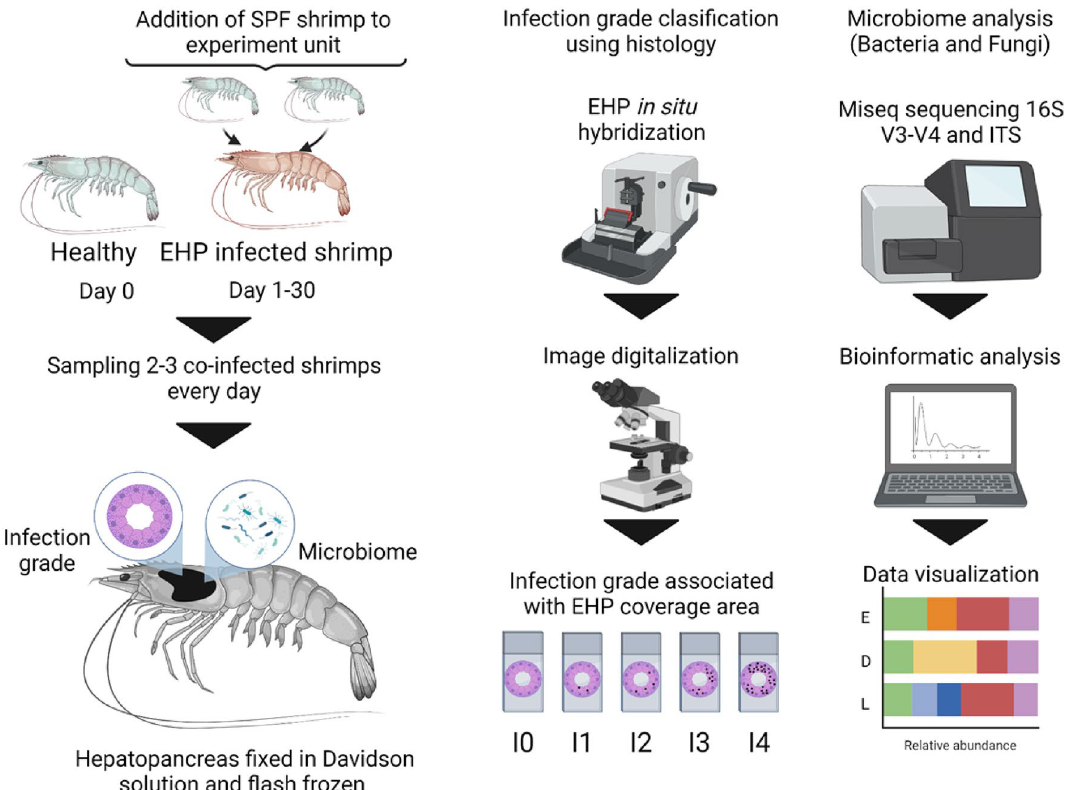
Figure 1. Work diagram and sampling collection. Experimental design to assess the bacterial and fungi community structure and predict hepatopancreatic microbiome functions in shrimp co-infected by EHP for 30 days. This image was created with BioRender (http:// biore nder.